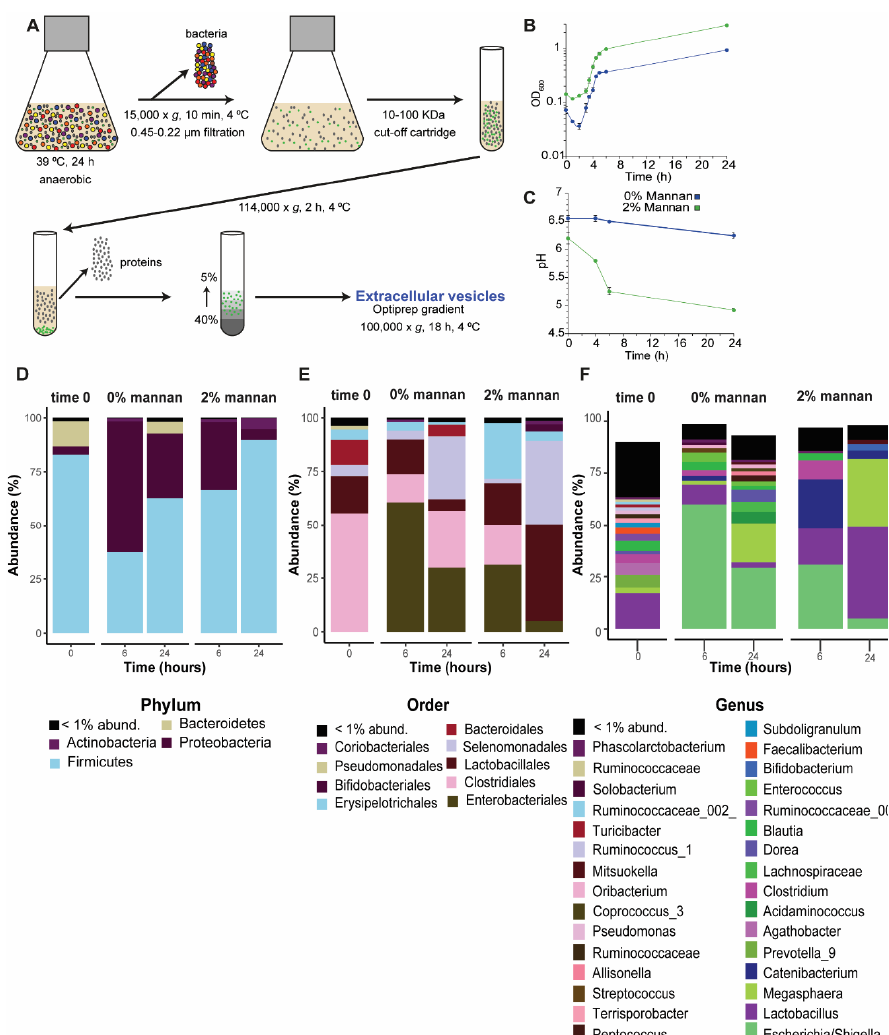
Figure 1. Methodology to isolate extracellular vesicles, EVs, and characterization of the bacterial community. Diagram showing the methodology used to isolate EVs in vitro, based on sequential centrifugation and density gradient separation ( A ). Growth curve of fecal inoculum cultivated in vitro in the presence of β-mannan or without any carbohydrate (control) ( B ). pH measurement of in vitro cultures either with or without the presence of β-mannan ( C ). Microbial diversity and composition in